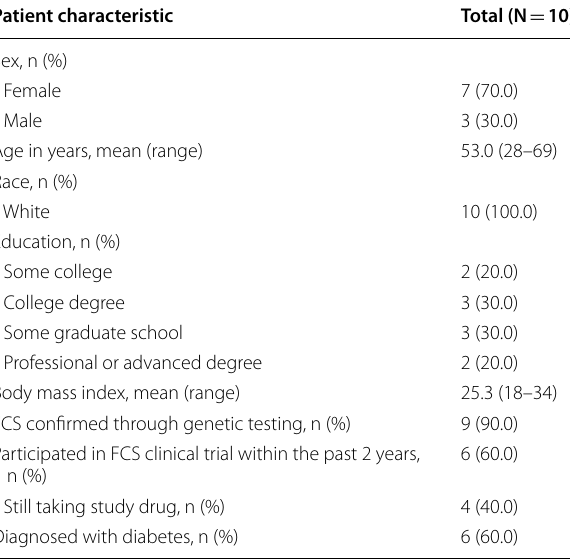
Table 1 Demographic and clinical characteristics of interview